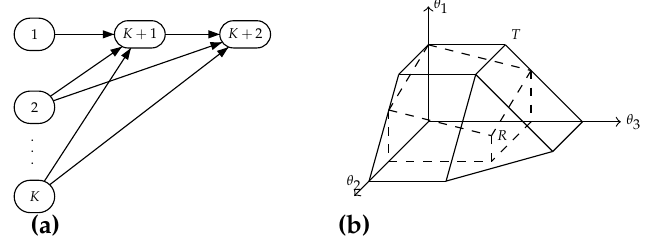
Figure 1. Directed graph ( a ) and polytopes T and R for K = 3 ( b ) exploiting the high probability of congestion even for competitive ratio less than